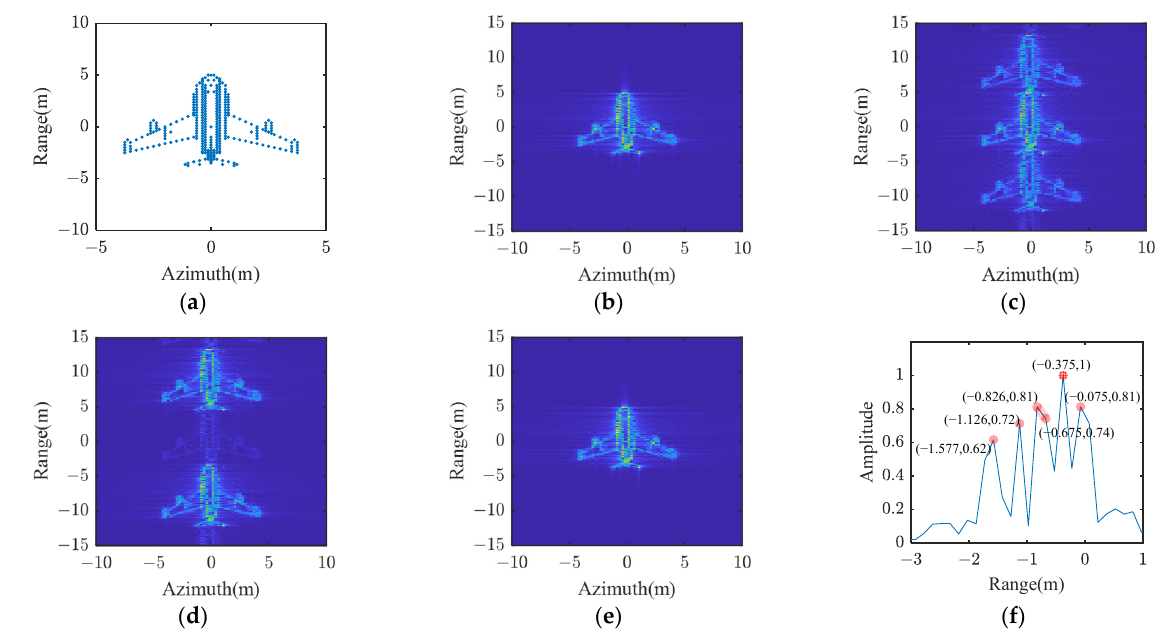
Figure 6. Imaging results of Yak ‐ 42 aircraft model: ( a ) Yak ‐ 42 aircraft model; ( b ) Imaging result of the complete LFM signal; ( c ) Imaging result of the first segment of the echo; ( d ) Imaging result of the combined echo; ( e ) Imaging result after cancellation; ( f ) Range profile with an azimuth of − 2 m. Figure 6a is the 330 scattering ‐ points model of the Yak ‐ 42 aircraft. The size is 8.75 m (range direction) × 7.5 m (azimuth direction). Assuming that the isolation between anten ‐ nas is high enough to ignore the coupling, we obtain the ideal ISAR imaging result of the complete LFM signal, as shown in Figure 6b. The duty ratio of the amplitude modulation function is D = 0.4. According to Section 2.3, the number of LFM signals continuously transmitted in each PRI is N = ⌈ 1/ D ⌉ = 3. After the target scattering, the first segment of the